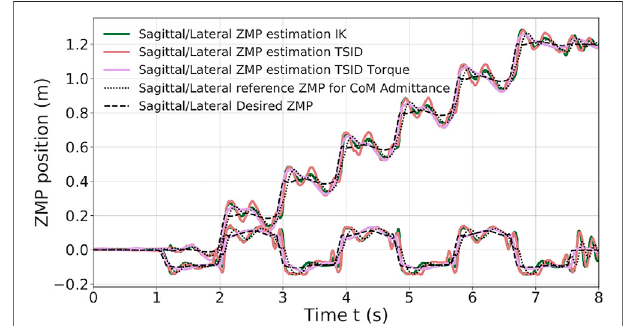
FIGURE 4 | ZMP estimation of the 20-cm step walk.